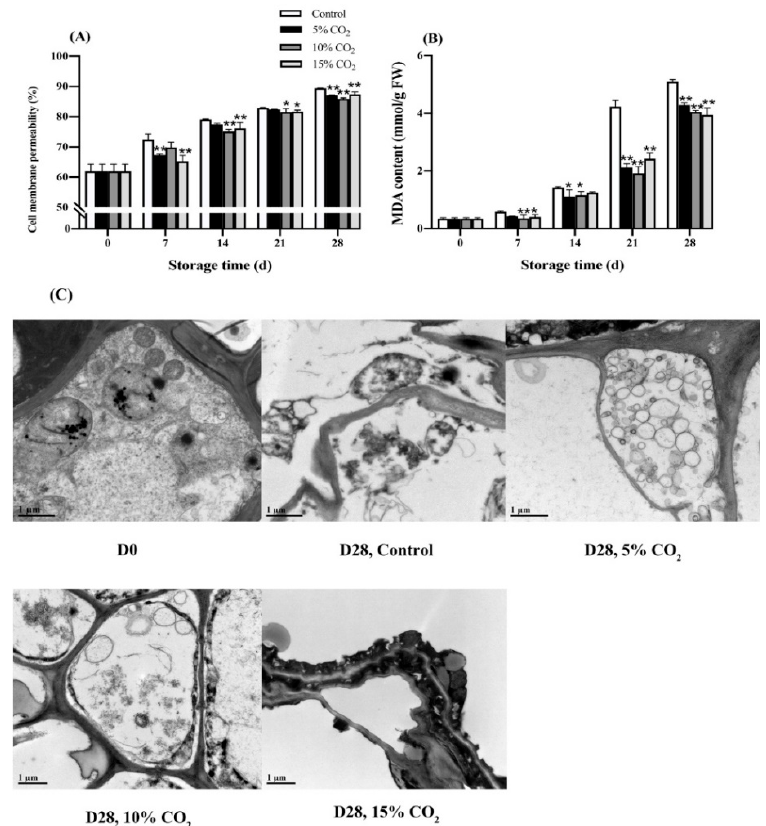
Figure 3. Effects of elevated CO 2 on cell membrane permeability ( A ), MDA (malondialdehyde) content ( B ), and ultrastructure ( C ) of wolfberry during storage at 0 ± 0.5 °C for 28 d. Significant level * p < 0.05; ** p < 0.01.